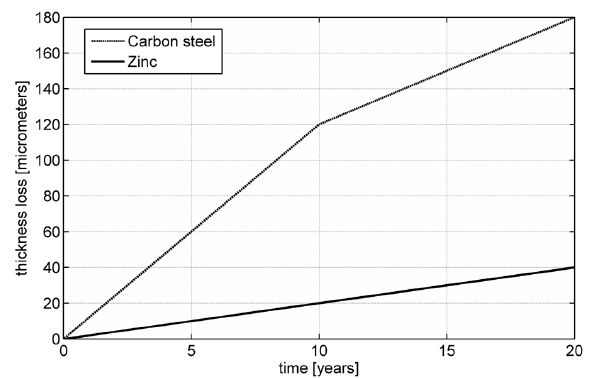
Fig. 2. A comparison between the corrosion rate of carbon steel and zinc in a medium corrosivity class C3 according to ISO 9224